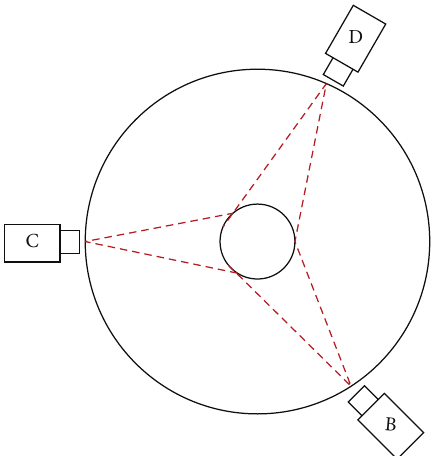
Figure 2: The illustrated diagram of the clamps lateral image acquisition.